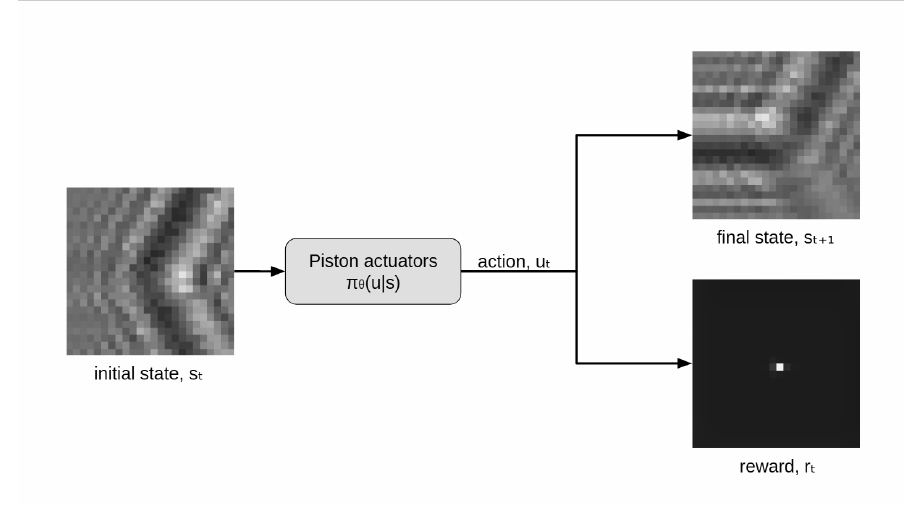
Figure 1. Diagram of one step Markov Decision Process.